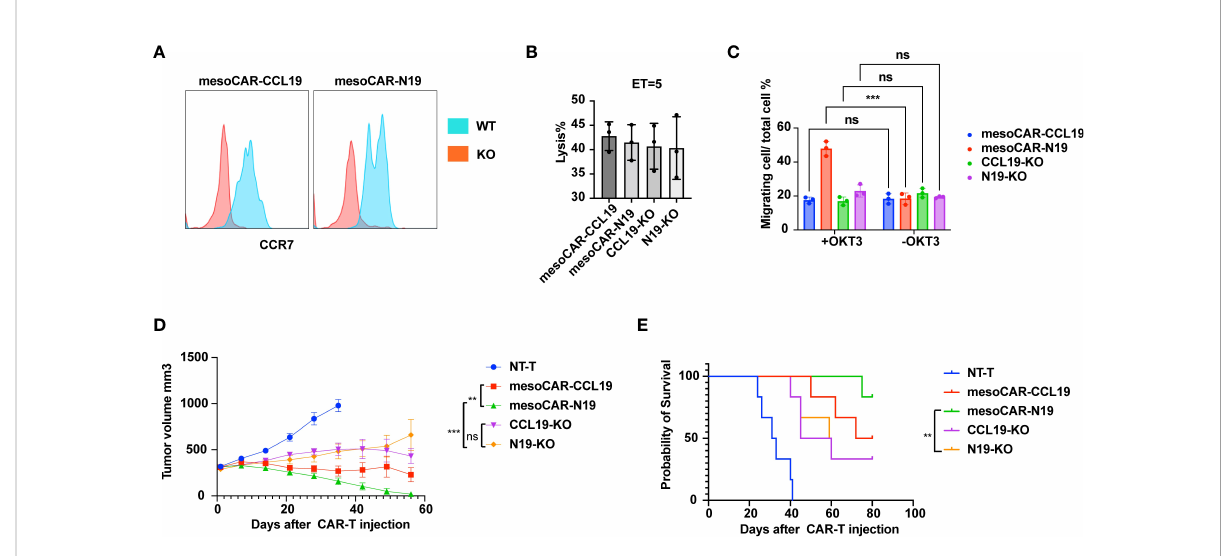
FIGURE 8 Functional assessment of C-C motif chemokine receptor 7 (CCR7) knockout in chimeric antigen receptor T (CAR-T) cells. (A) CCR7 expressing detection on surface of wild type or CCR7 knockout CAR-T cells; (B) Tumor cell lysis assessment in vitro at 5 ET ratio(n = 6); (C) Migratory capacity estimation using Transwell assays (n = 6); (D) Tumor suppression curve; (E) Mouse survival presented as Kaplan-Meier curves (n =6). Error bars represent the mean ± standard deviation (n = 6). **P<0.01;***P<0.001; ns, no signi fi